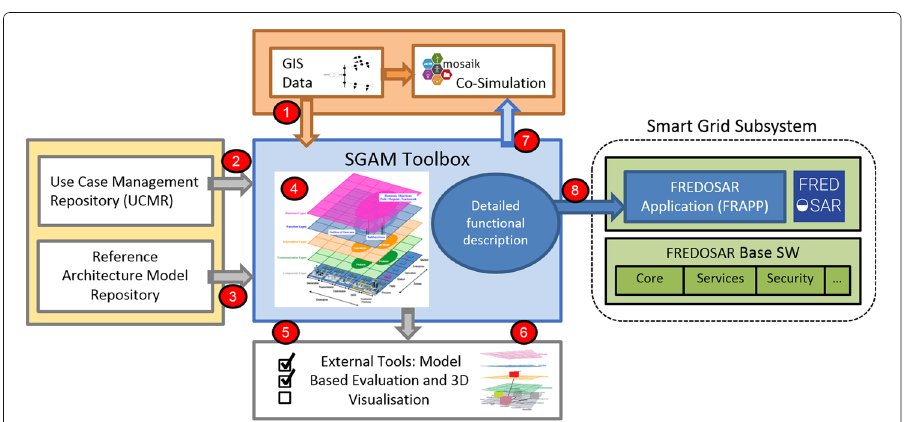
Fig. 2 System of Systems “Integration Toolchain” for Smart